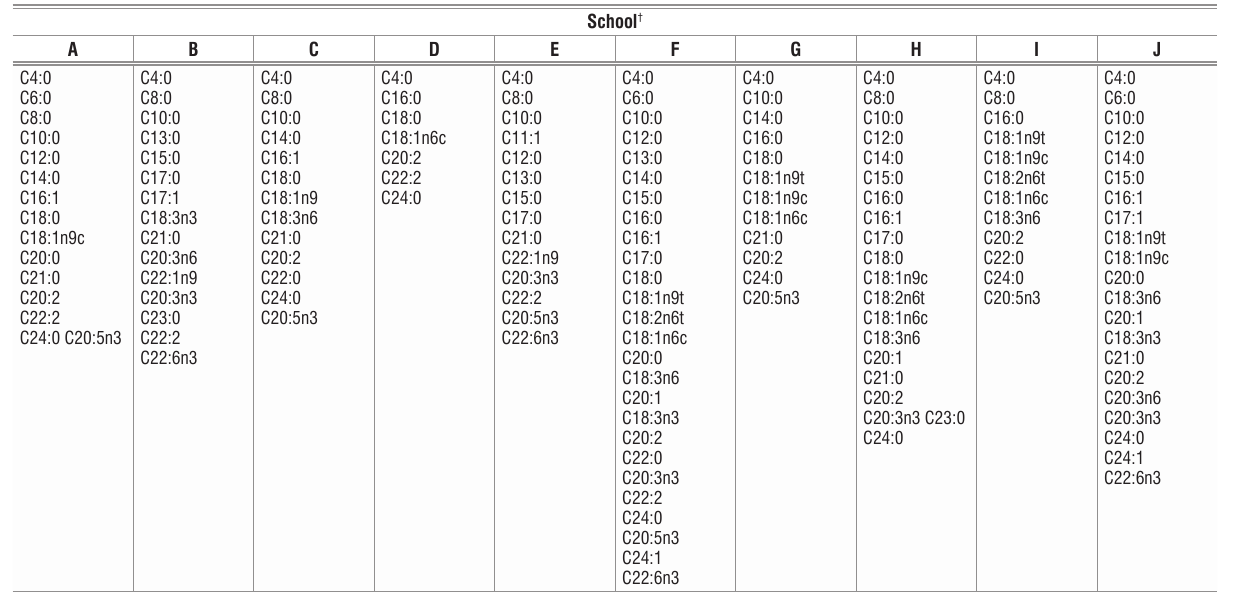
Fatty acid compositions of meals served in schools in the National School Nutrition